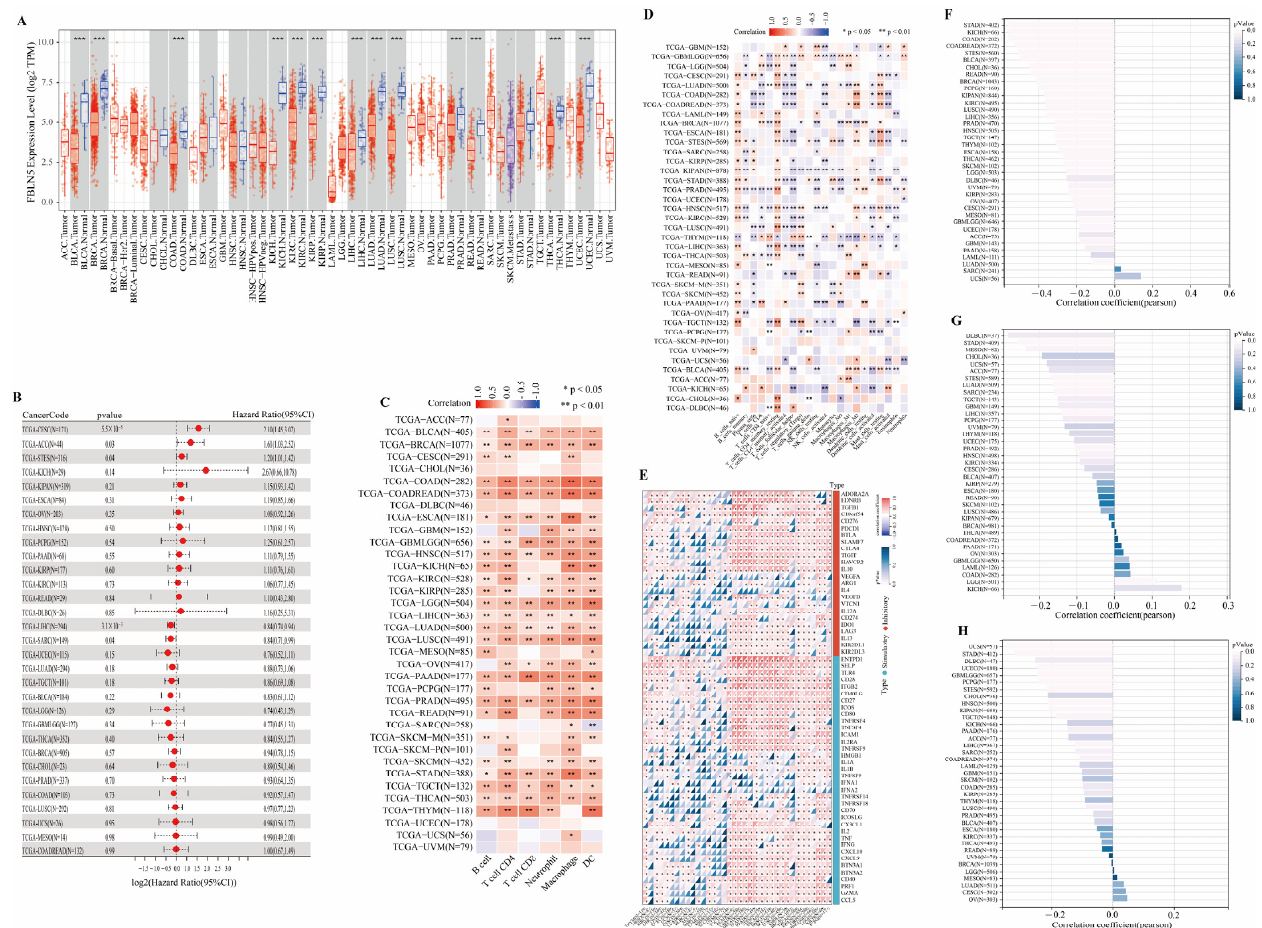
Figure 7. Application of FBLN5 in other cancers. ( A ) Expression levels of FBLN5 in various cancers. ( B ) Prognostic analysis of FBLN5 in various cancers. ( C ) TIMER algorithm and ( D ) CIBERSORT algorithm preliminarily predicted the relationship between the expression level of FBLN5 and immune infiltration in various types of tumors. ( E ) Pan-cancer analysis of FBLN5-related immune checkpoints, along with ( F ) tumor purity, ( G ) TMB, and ( H ) MSI analyses to evaluate the prospect of using FBLN5 for targeted pan-cancer treatment. * p < 0.05, ** p < 0.01, *** p <